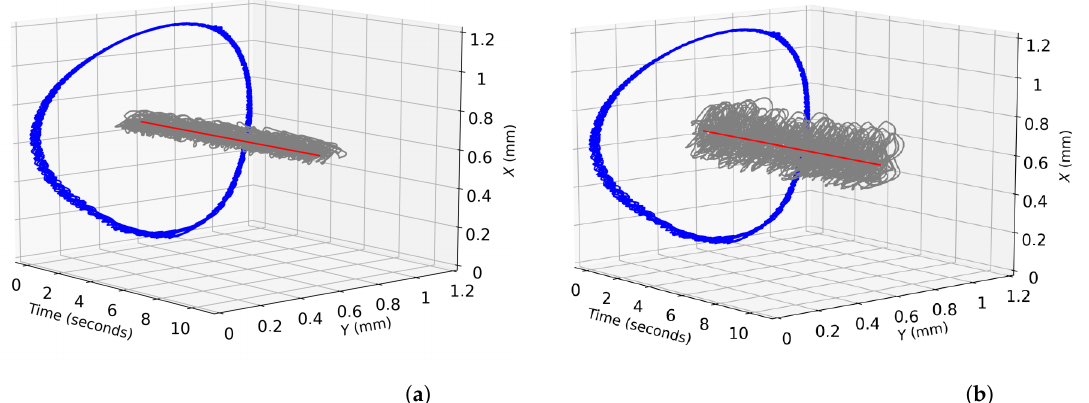
Figure 14. Steady state response of radial position control for the linear and nonlinear controllers in 3D. ( a ) Linear ADRC. ( b ) Nonlinear ADRC.